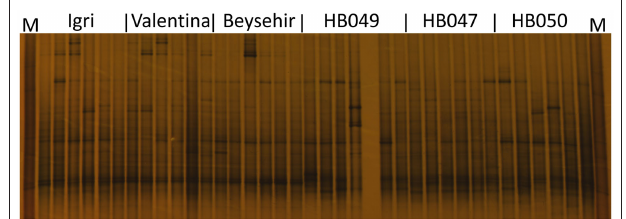
FIGURE 4 | Bacterial rhizosphere communities of elite cultivars (Igri, Valentina, and Beysehir) and ancestral genotypes (HB049, HB047, and HB050) of barley, analyzed by denaturing gradient gel electrophoresis of 16S rRNA gene fragments ( n = 6 replicate fingerprints per genotype, each replicate sample was derived from microbial extracts of roots and adhering soil of two plants). M: a marker of cloned 16S rRNA variants.